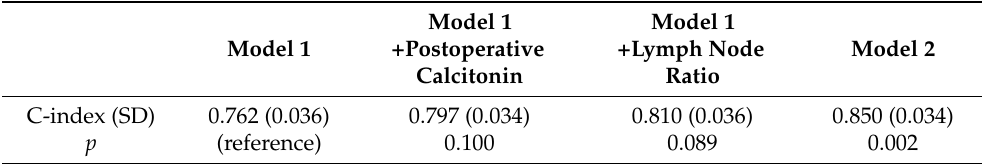
Table 5. Comparison of predictive power between